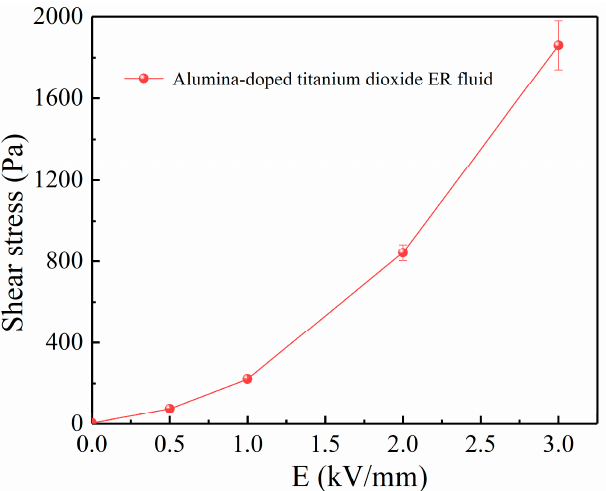
Figure 6. Shear stress as a function of electric field intensity for alumina-doped titanium dioxide ER polishing fluid (volume fraction = 20%, shear rate = 1 s − 1 ).